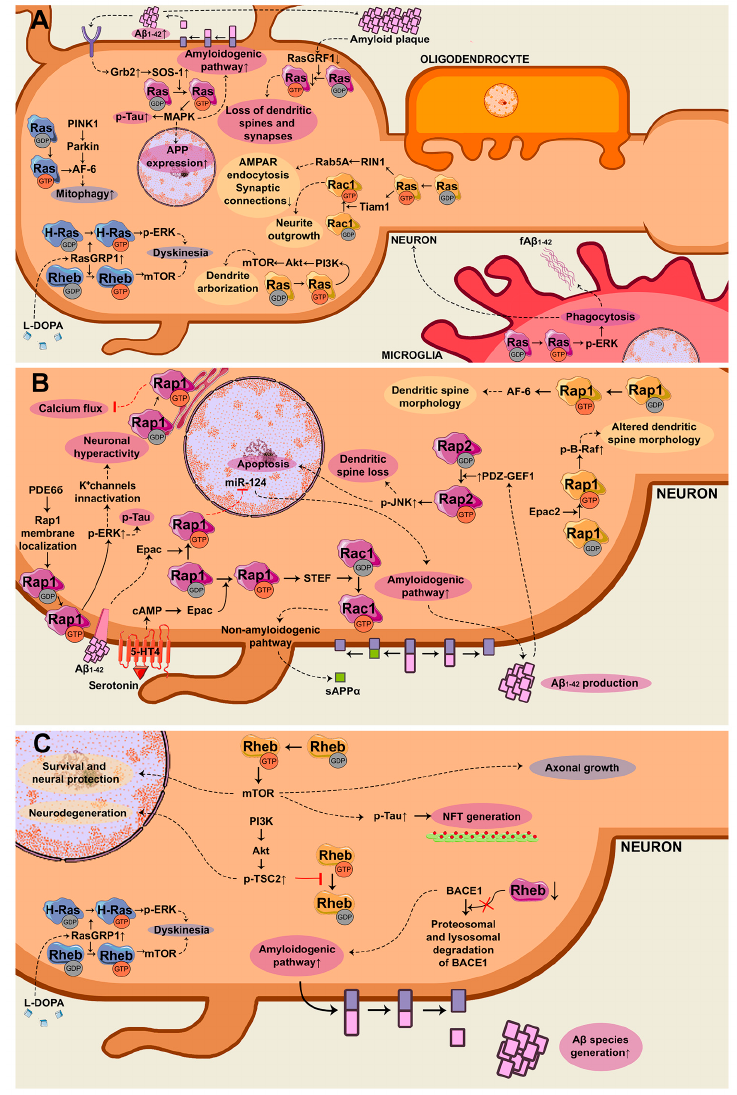
Figure 2. Scheme of the signaling pathways controlled by small GTPases of the Ras family, which are deregulated in general (yellow), in Alzheimer’s disease (AD) (purple), and Parkinson’s disease (PD) (blue) in neurodegenerative diseases. ( A ) Signaling pathways controlled by Ras GTPase in neurons and microglia. Growth factor receptor-bound protein 2 (Grb2) / SOS-1 / Ras / mitogen-activated protein kinase (MAPK), decreased RasGRF1 / Ras, Ras / afadin-6 (AF-6), and Ras / RIN1 promote di ff erent responses that induce neurodegeneration. Ras / Tiam1 and Ras / PI3K in neurons, and Ras / extracellular signal-regulated kinase (ERK) in microglia, which could be altered in neurodegenerative diseases. ( B ) Signaling cascade controlled by Rap GTPases in neurons. Rap1 / MAPK and PDZ-GEF1 / Rap2 / c-Jun N-terminal kinase (JNK) favor neurodegenerative processes. Rap1-induced miR-124 inhibition increases the production of toxic amyloid- β (A β ). PDE6 δ controls Rap1 / MAPK pools that are driving to neurodegenerative responses. However, Rap1 / STEF / Rac1 is inducing a protective phenotype. ( C ) Signaling axis controlled by Rheb GTPase. Rheb / mTOR can or cannot drive neurodegeneration depending of the input in neurons. Furthermore, reduced Rheb protein levels provoke a reduction in BACE1 degradation, which induces the generation of A β